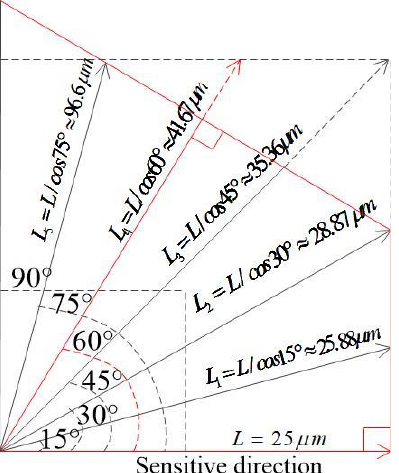
Figure 2. ( a ) The schematic diagram of a triangular movable electrode acting in a sensitive direc- tion; ( b ) the movable electrode contacts with the fixed electrode in a sensitive direction; ( c ) the schematic diagram of a triangular movable electrode acting in a non-sensitive direction; ( d ) the movable electrode contacts with the fixed electrode in a non-sensitive direction.